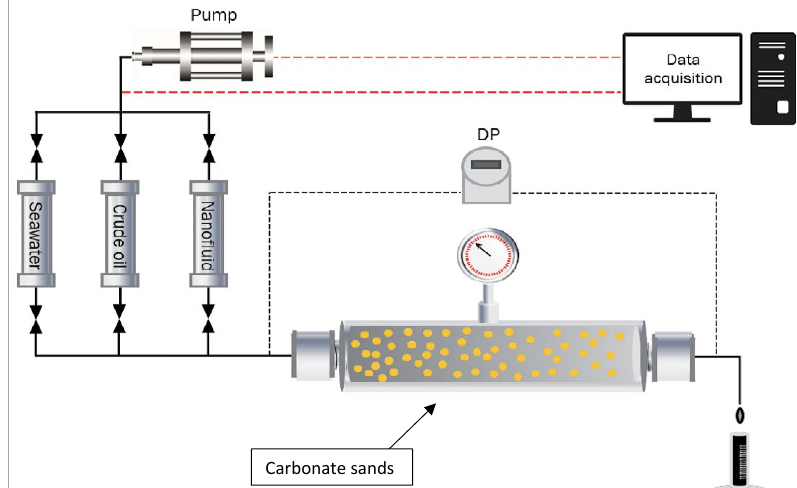
Fig. 6: Schematic view of the sand pack flooding setup used in this Fig. 6. Schematic view of the sand pack flooding setup used in this experiment.